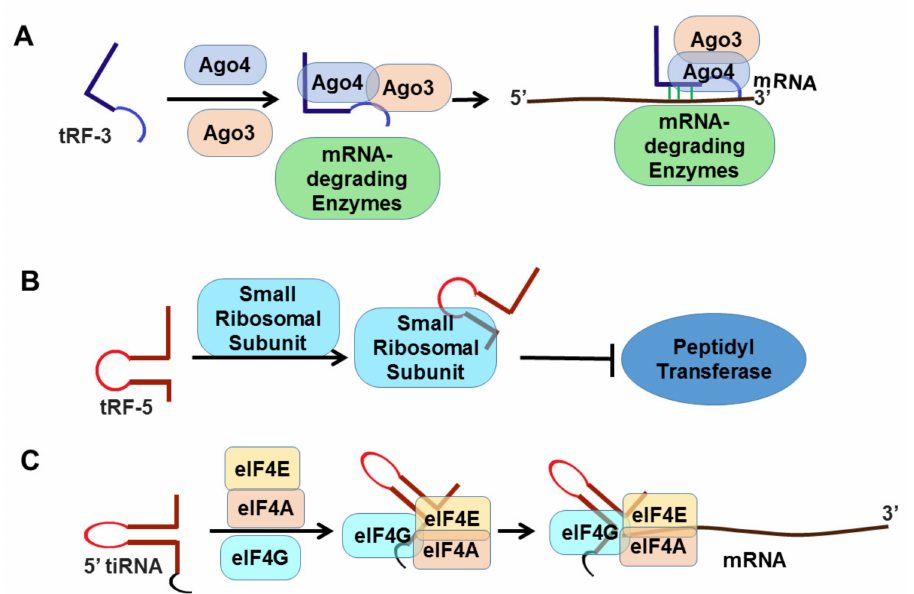
Figure 3. tRF- and tiRNA-mediated gene regulation: ( A ) Regulation of mRNA stability: The com- bination of tRF-3 with argonaute 3 (Ago3) and Ago4 binding to mRNA allows mRNA-degrading enzymes to degrade the target mRNA [101]; tRFs function like miRNAs to inhibit cancer-associated gene expression. Binding with the 3 (cid:48) untranslated region (3 (cid:48) UTR) of target mRNA, Argonaute (Ago) protein and other proteins form an RNA-induced silencing complex (RISC). ( B , C ) Inhibition of translation: By binding to small ribosomal subunits, tRF inhibits peptidyl transferase activity that results in reduced protein abundance of the target gene [99,102]. 5 (cid:48) tiRNA inhibits translation by forming a RNA G-quadruplex (RG4s) that replaces the translation initiation complex eIF4G/eIF4E on the mRNA cap